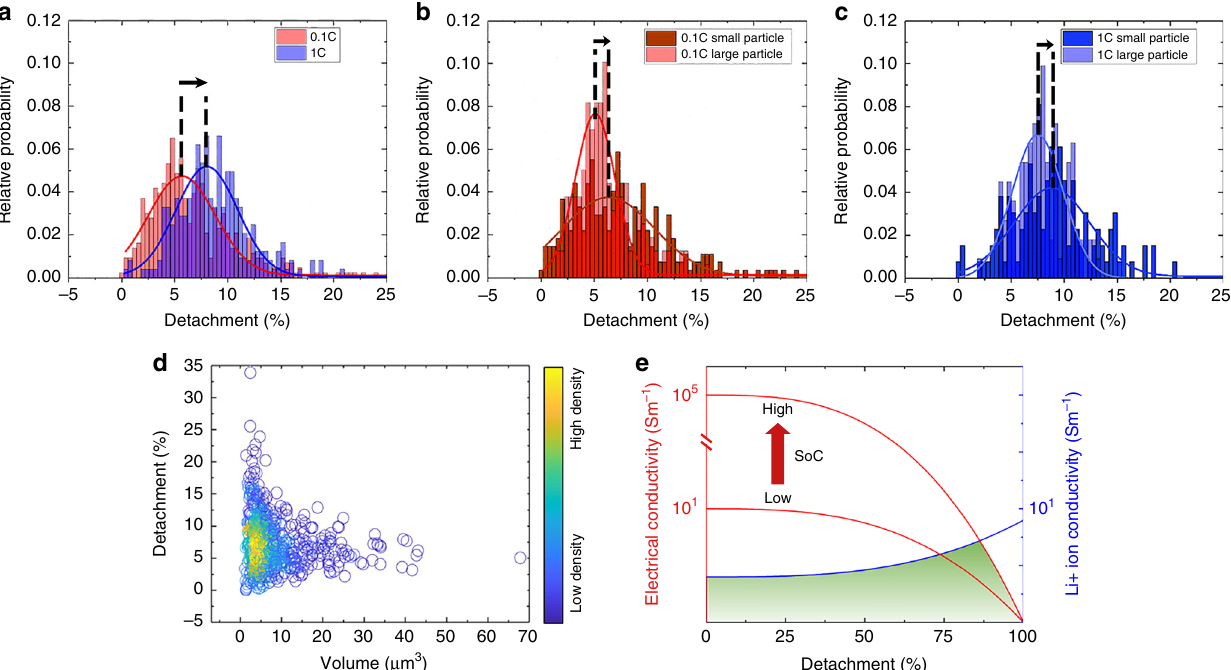
Fig. 4 Statistical analysis of the particle detachment. Statistical comparisons of the degree of particle detachment from the CBD matrix are carried out as a function of cycling rate ( a ) and particle size ( b , c ), respectively. The degree of particle detachment is also plotted against the respective particle volume in ( d ) for all the 650 NMC particles studied in this work. e Schematic of the changes of the electrical (red) and ionic (blue) conductivity as a function of the particle detachment. The red curve moves up and down depending on the SoC. The particle ’ s actual contribution falls in the green shaded